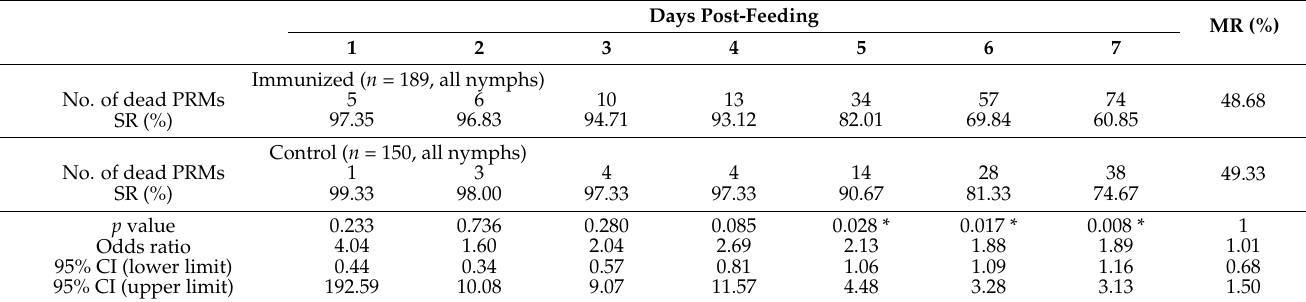
Table 2. Summary of the anti-PRM property of Dg-Cys -his immunization (second experiment).